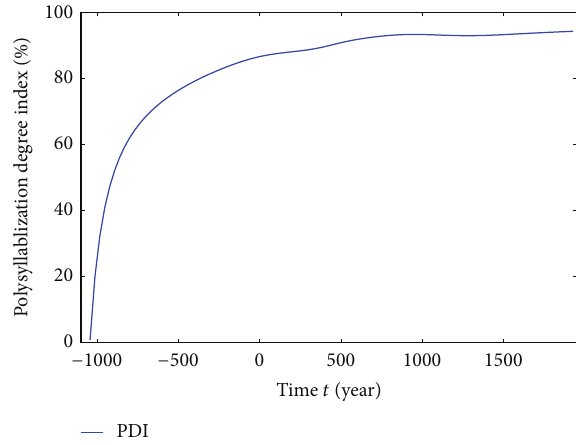
Figure 2: The speed of the word production.